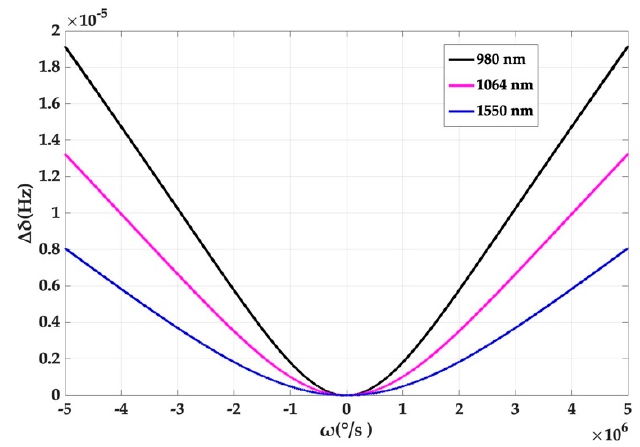
Figure 5. The relationship between the splitting value deviation and the angular rate at different